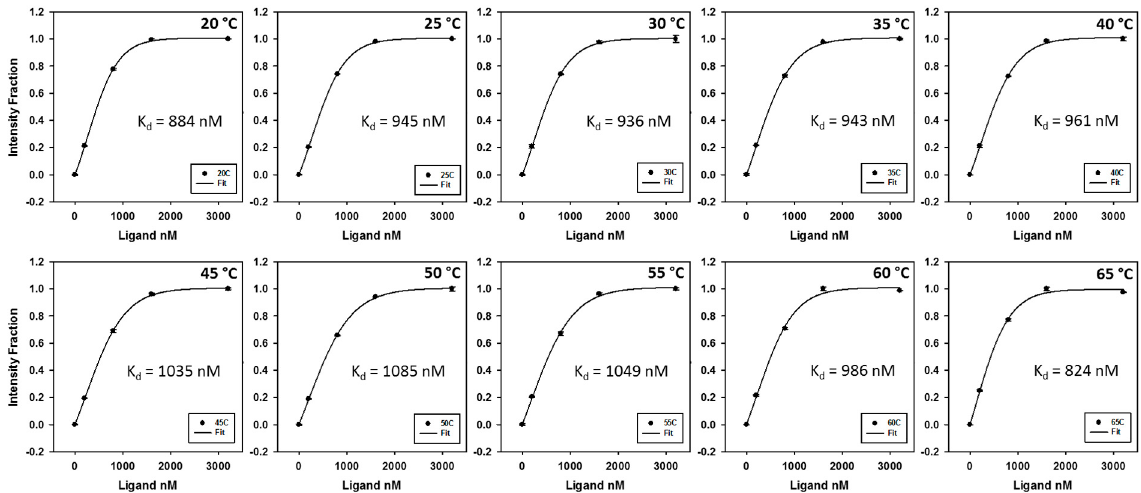
Figure 5. Sigmoidal fitting of sisomicin binding data and calculated K d values at 20–65 °C. Annealed FM1 r(CUG) 10 RNA sample concentration 200 nM and volume size 150 µL; sisomicin addition volume size 1.5 µL with ligand to RNA molar ratios of 0, 1, 4, 8, and 16; fluorescence setting: excitation at 485 nm, emission at 500–600 nm, and slit width of 3 nm.